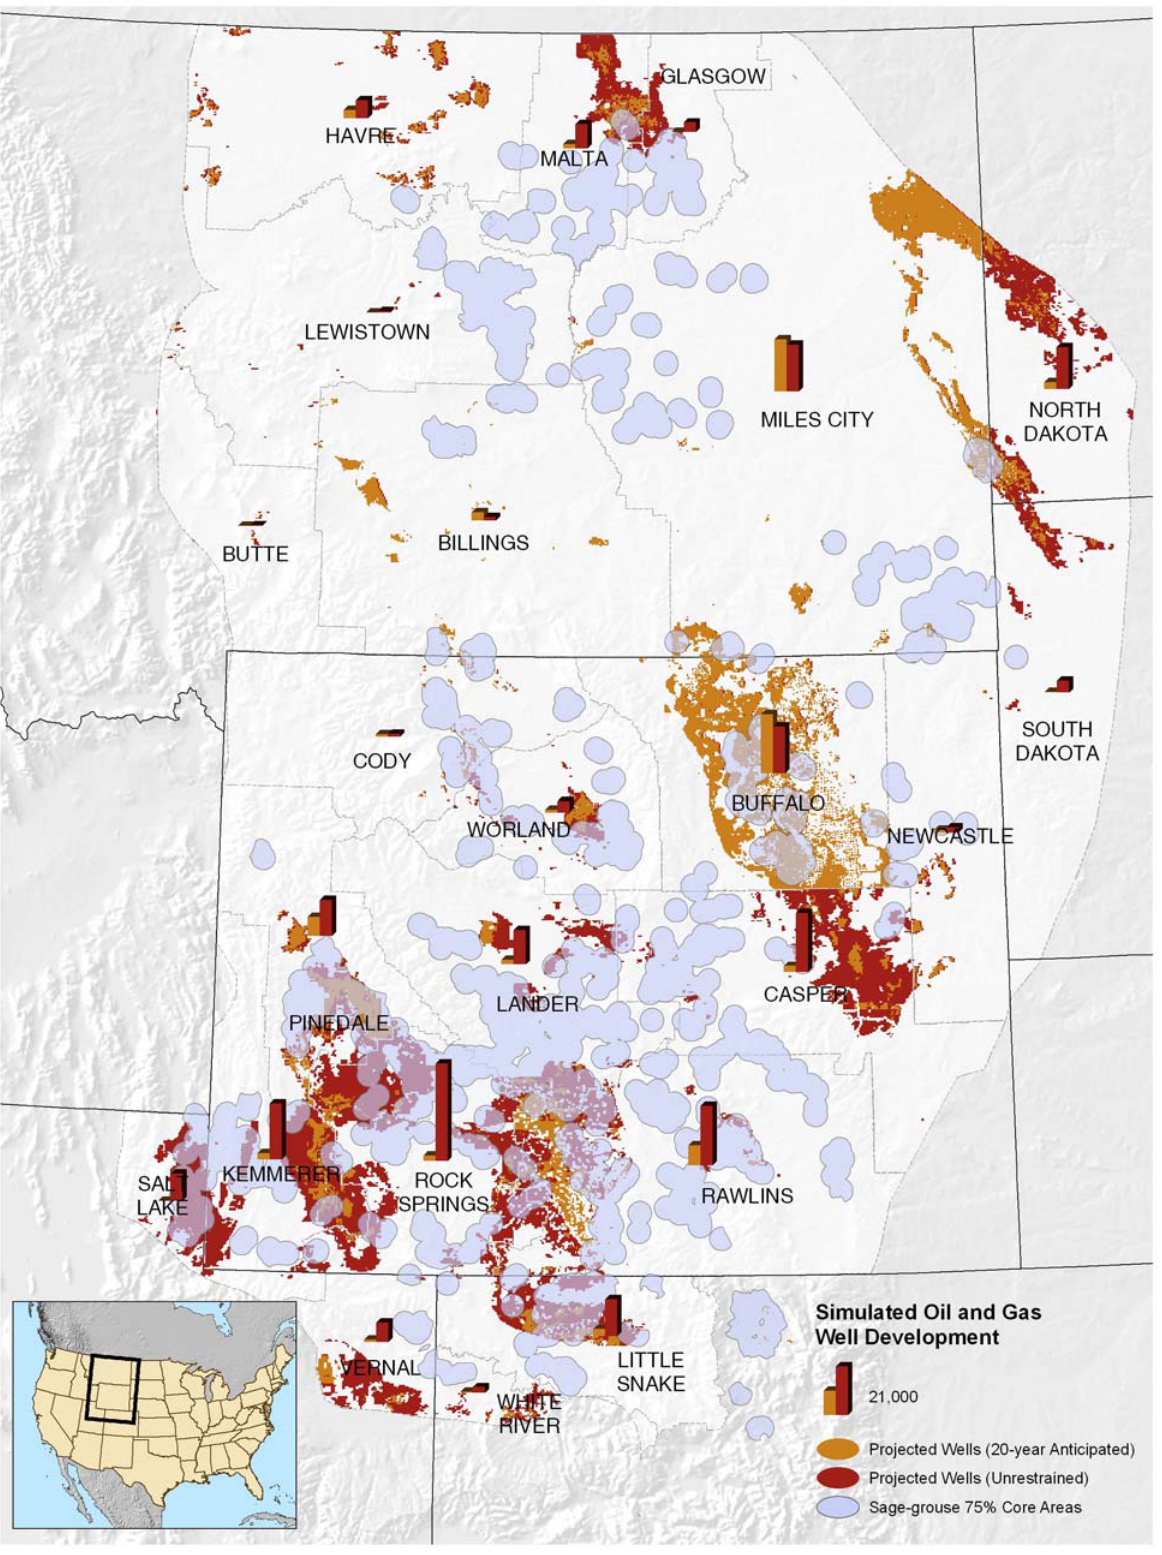
Figure 2. Oil and gas simulation results for the two scenarios. This map illustrates the location and extent of expected development in the two scenarios. Areas in orange depict growth for the anticipated scenario. Areas in red depict growth for the unrestrained scenario. Bar graphs show the quantity of development projected for each scenario. Core areas for sage-grouse are shown to highlight expected areas of future conflict ([46]).